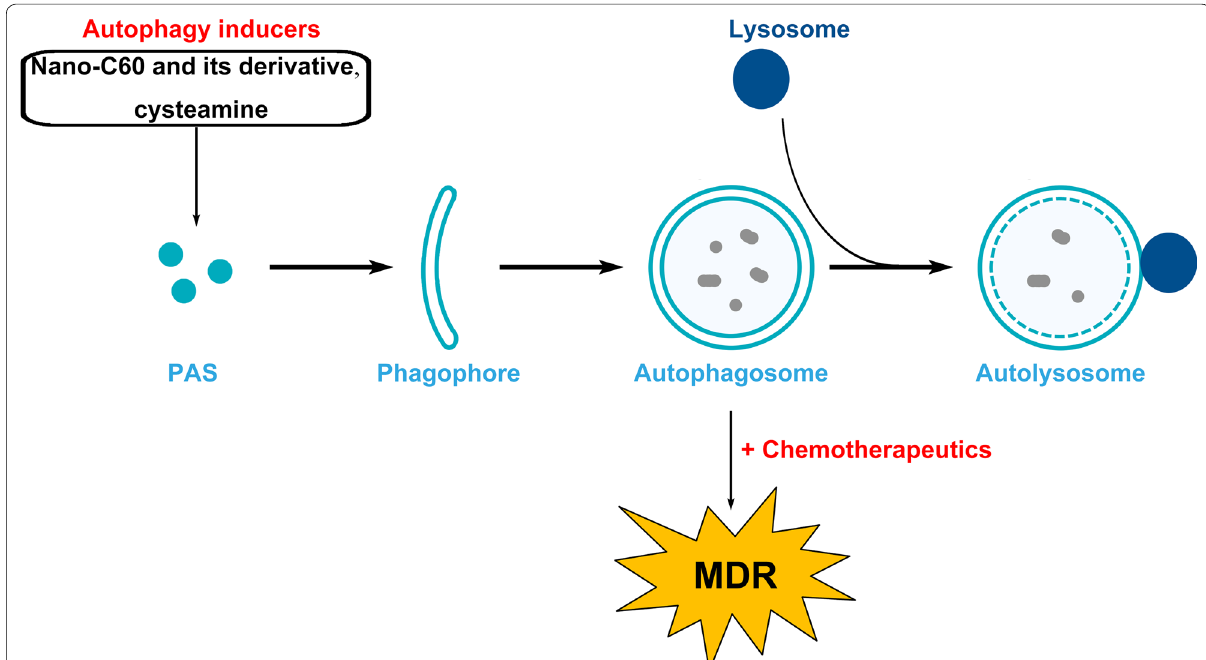
Fig. 2 Autophagy chemosensitizes MDR cancer cells to chemotherapeutics. A novel role of autophagy induced by certain autophagy inducers such as cysteamine, the nanocrystal of underivatized fullerene C60 (nano‑C60) and its derivative was confirmed. Autophagy triggered by those inducers could sensitive MDR cancer cells to chemotherapeutics. PAS, pre‑autophagosomal